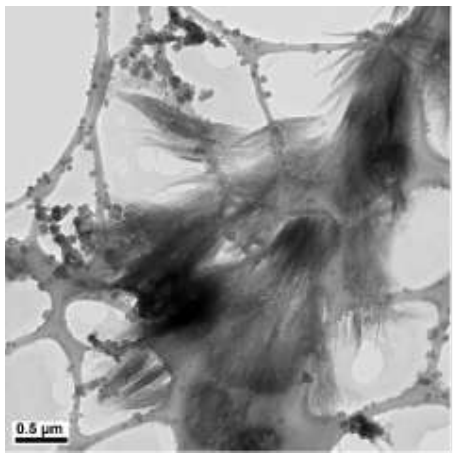
Figure 6. TEM images of copper products at 80 ◦ C: ( a ) scale bar 0.5 µ m; ( b ) scale bar 100 nm.